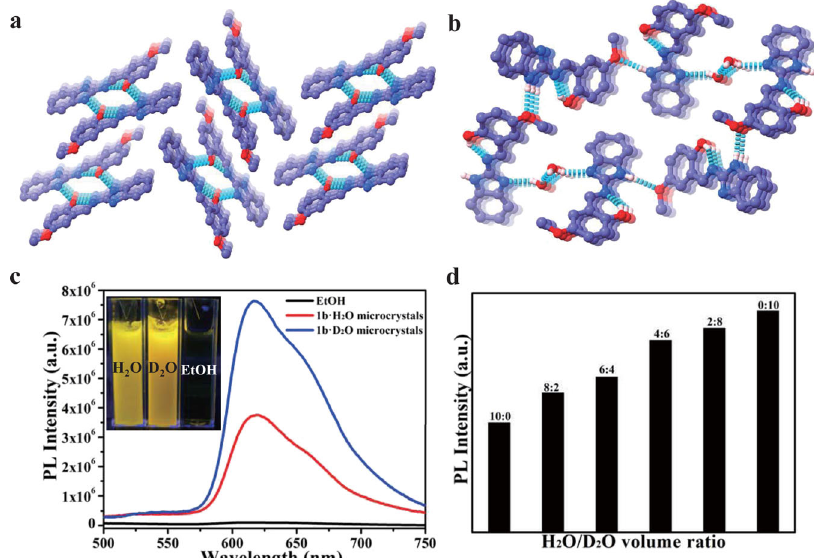
Fig. 2 Molecular stacking and photoluminescence results. Molecular stacking of prepared single crystals: a 1b and b 1b·H 2 O . Multiple intermolecular and intramolecular hydrogen bonds in the single crystals are denoted by dotted lines. c Emission spectra ( λ ex = 400nm) of 1b (1 × 10 − 5 M) in ethanol and 1b·H 2 O (D 2 O) microcrystal dispersion in water or deuterium oxide; d changes in relative photoluminescence intensity with respect to different ratios of H 2 O and D 2